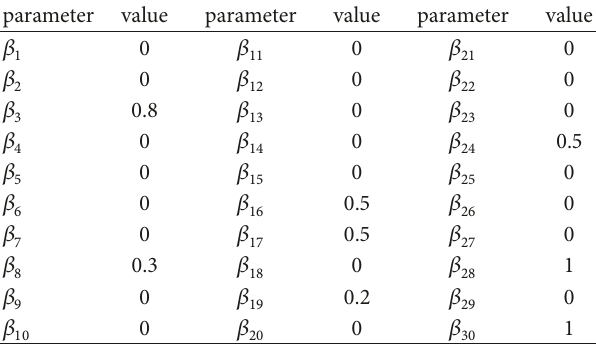
Table 4: The weight of the different context